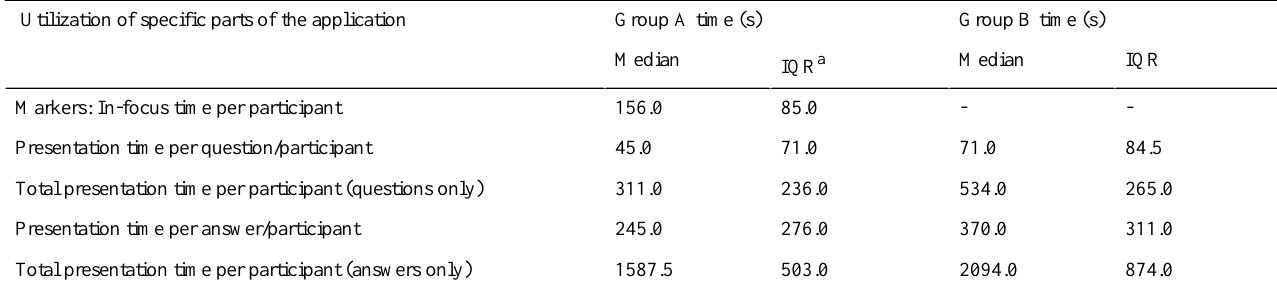
Table 5. Utilization times in seconds (median values and interquartile ranges) for the markers (in-focus time span), marker interaction, and flashcards (questions and answers) stratified by group (group A with mobile Augmented Reality [mAR], group B without mAR functionality, both